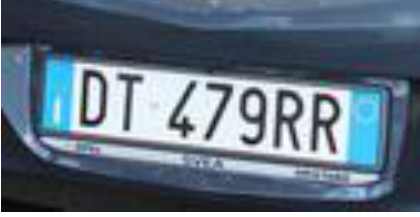
Figure 6. Rescaled input